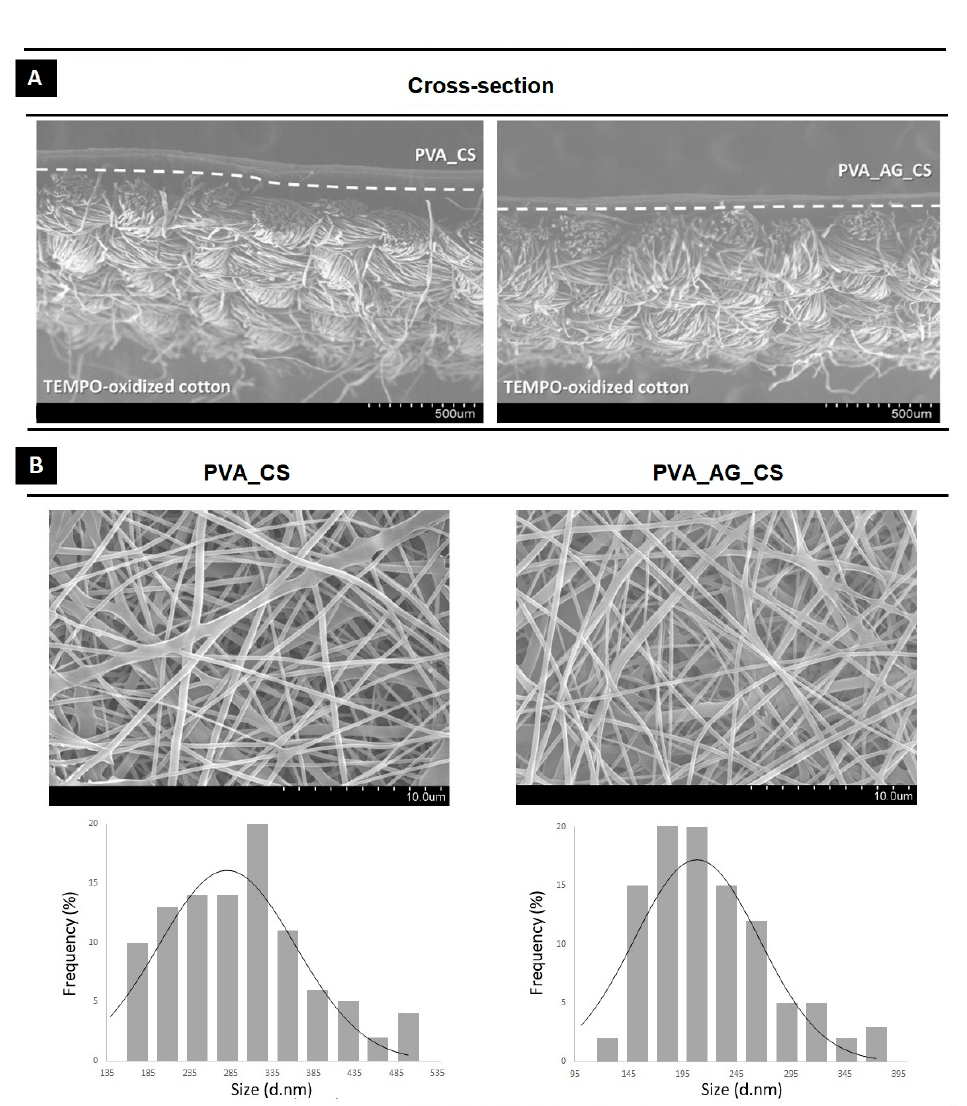
Figure 2. Morphological characterization of the produced 2,2,6,6-tetramethylpiperidine-1-oxyl radical (TEMPO)-oxidized cotton/ Poly(vinyl alcohol) (PVA)_Chitosan (CS) materials with and without crude Agrimonia eupatoria L. (AG) extract. SEM images of the cross-sections ( A ); surface morphologies and diameter distribution of the coating layers of PVA_CS and PVA_AG_CS nanofibers ( B ).